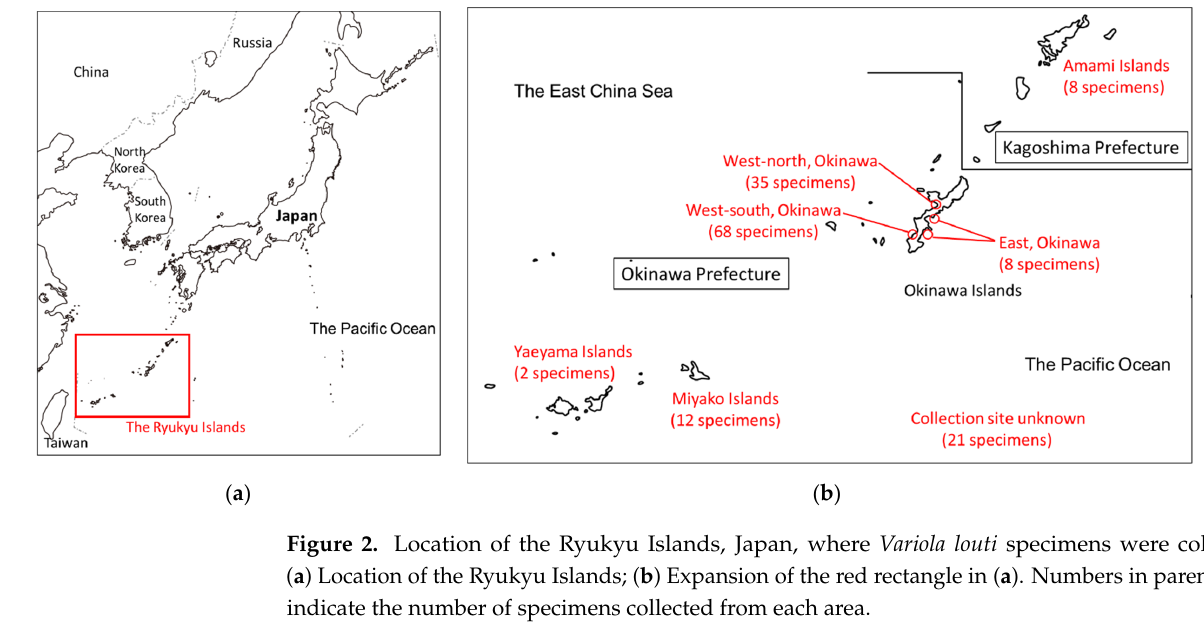
Figure 2. Location of the Ryukyu Islands, Japan, where Variola louti specimens were collected. ( a ) Location of the Ryukyu Islands; ( b ) Expansion of the red rectangle in ( a ). Numbers in parentheses indicate the number of specimens collected from each area.